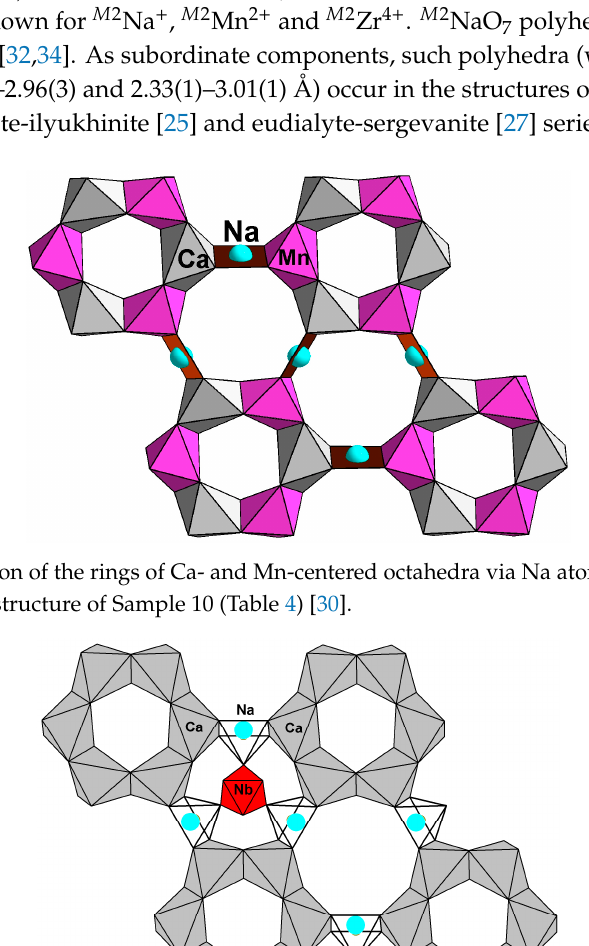
Figure 8. M 2-centered octahedra in Sample 4 (Table 4) [29].